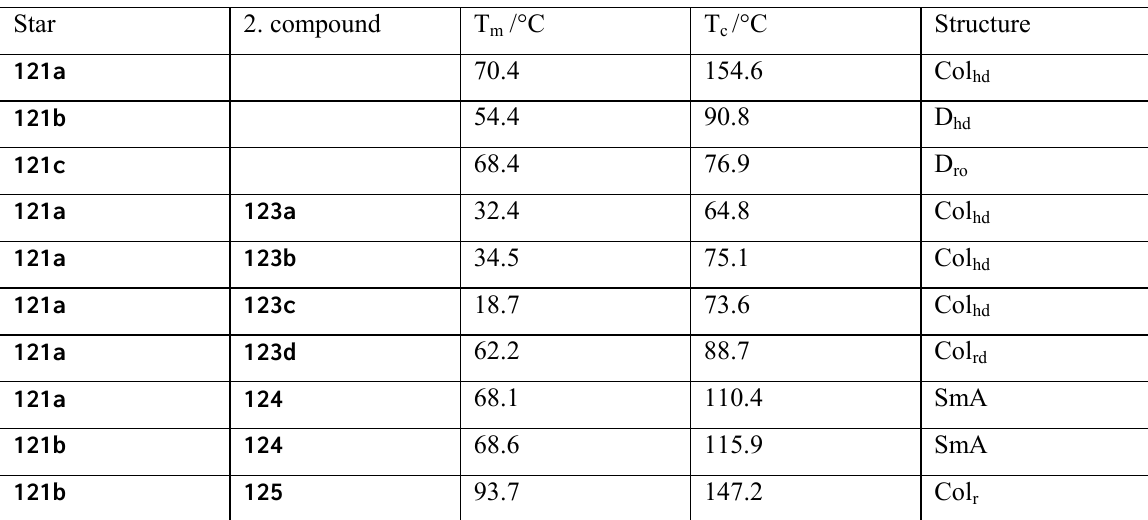
Table 8. Phase transition temperatures of tris-3,4-dialkoxyarylmelamines 121a-c and